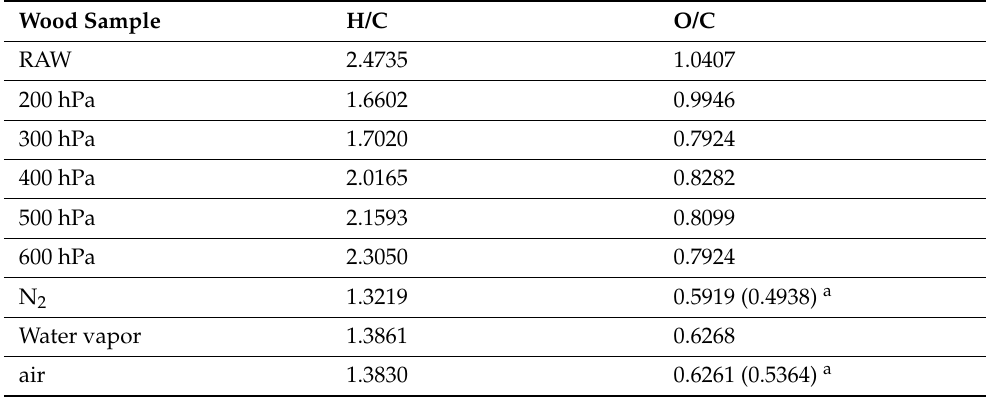
Table 2. Elemental analysis results for poplar samples treated under different pressures (200–600 hPa) and atmospheres (N 2 , water vapor, and